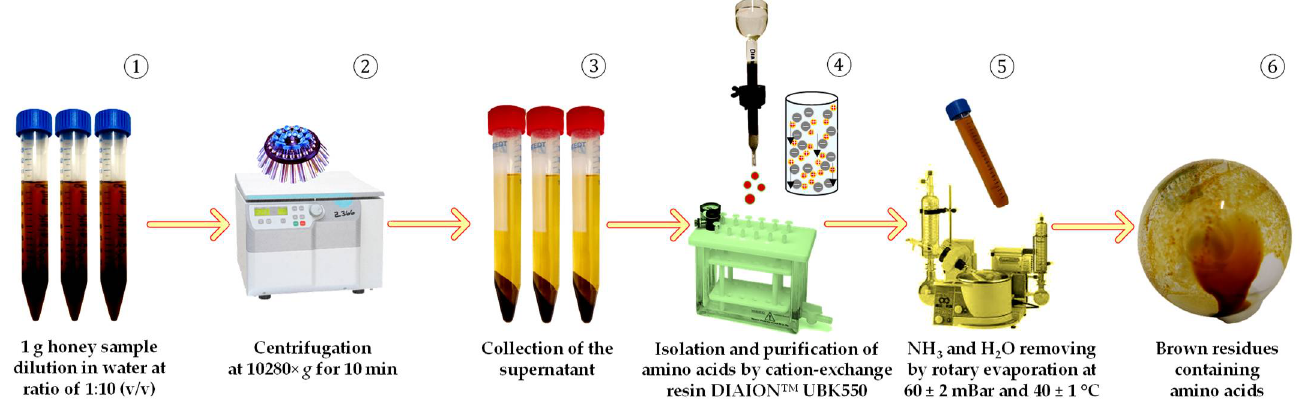
Figure 1. A schematic representation of the sample preparation steps undertaken for the extraction and purification of amino acids present in honey matrix.